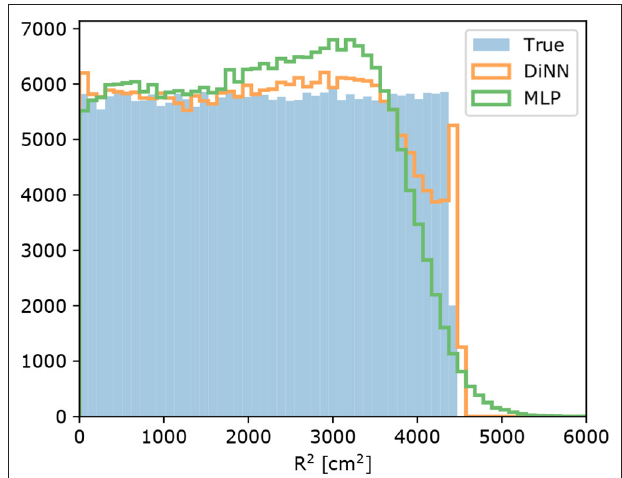
FIGURE 9 | Radial distribution of simulated single electron S2 signals. The MLP model localizes 2,346 of 250,000 S2s outside the detector, while the DiNN model localizes all of them inside the detector with the output constraint.